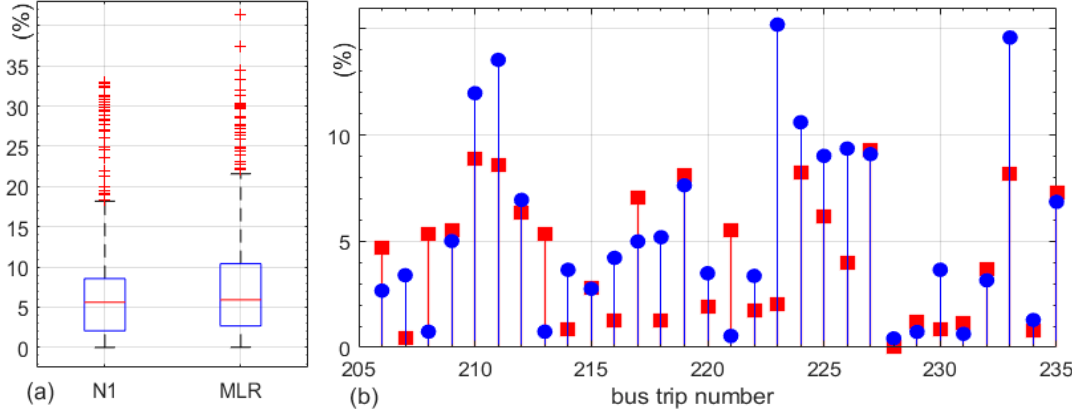
Figure 10. Absolute value of estimation errors for best network and regression model: ( a ) box plots and ( b ) stem plot of an example range of bus trips used in testing.